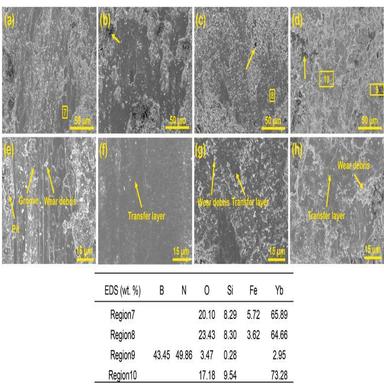
SEM images and EDS results of the wear tracks of the Y–0BN (a, e), Y–5BN (b, f), Y–10BN (c, g), and Y–15BN (d, h) coatings under 0.7 m/s.